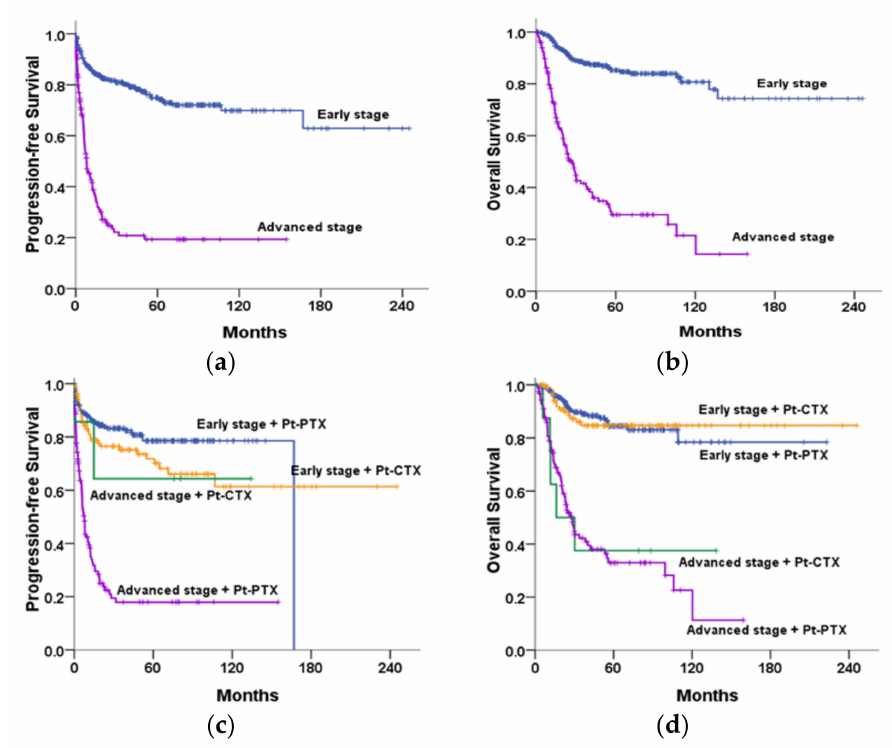
Figure 2. Kaplan–Meier curves. ( a ) Progression-free survival (PFS) and ( b ) overall survival (OS) significantly differed between patients with early- ( n = 371) and advanced-stage OCCC ( n = 150). ( c ) PFS and ( d ) OS significantly differed between the subgroups stratified by stage plus platinum- based